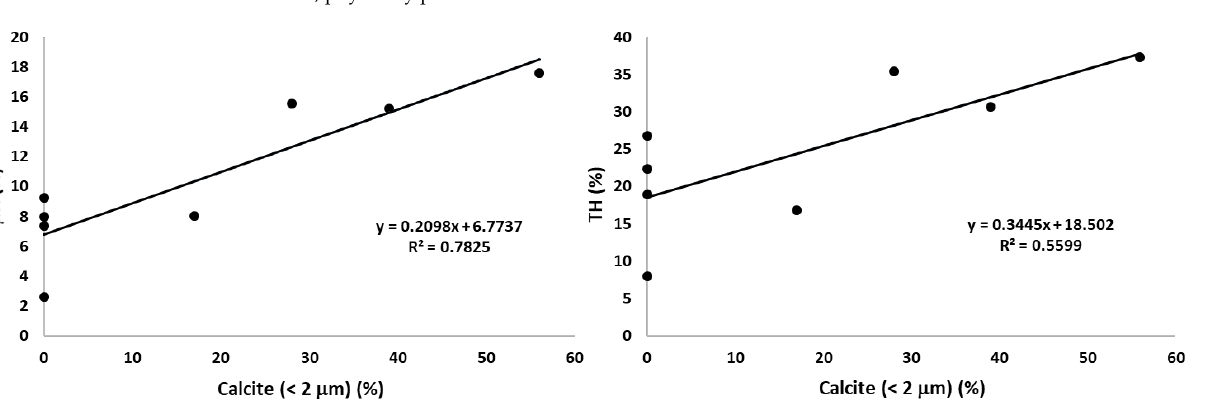
Figure 6. Correlations between the hydrolysable fractions and the calcite in clay. µ H: hydrolysable fraction, physically protected; TH: H plus µ H.